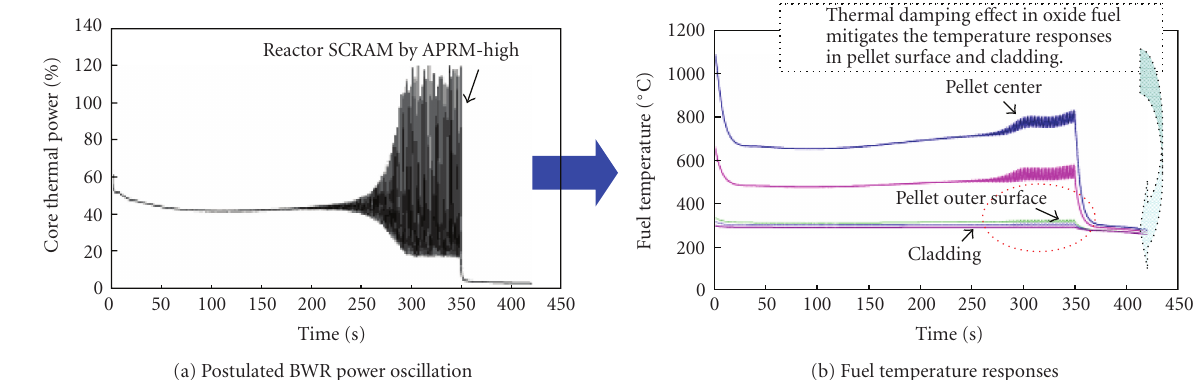
Figure 14: Fuel temperature responses under the representative BWR instability.